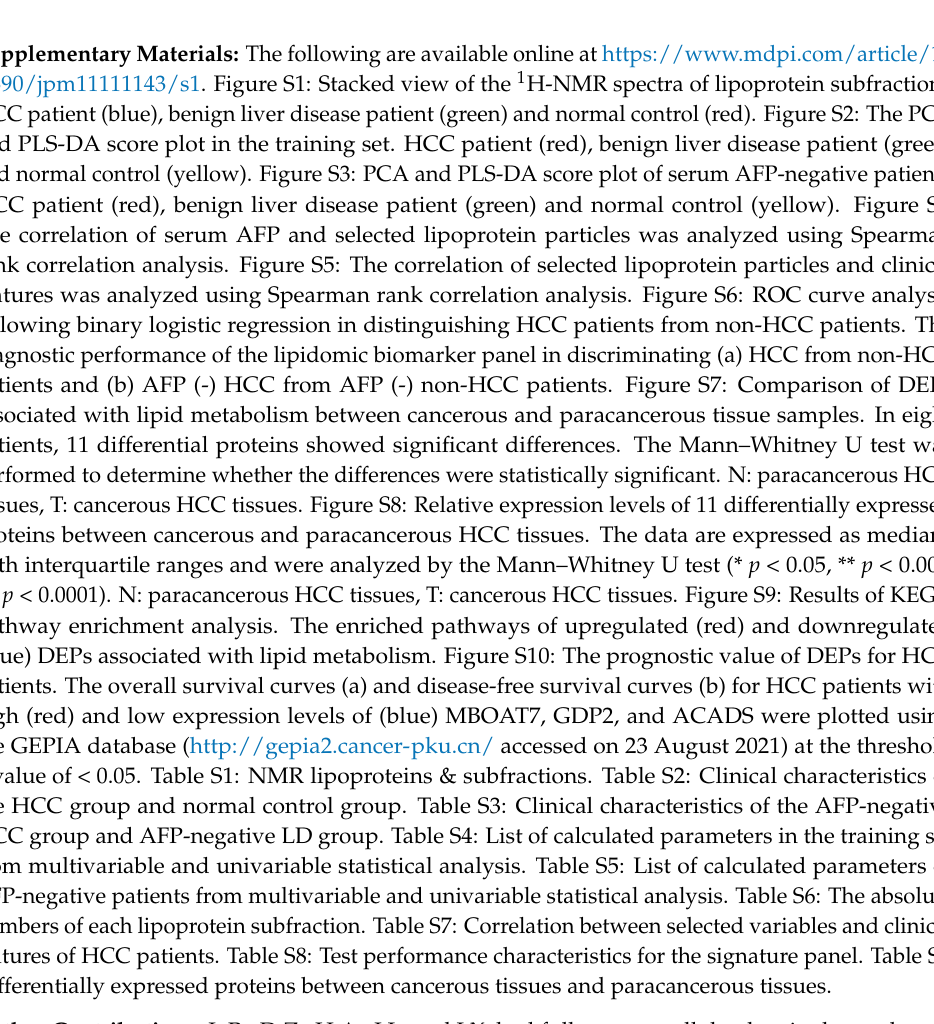
features of HCC patients. Table S8: Test performance characteristics for the signature panel. Table S9: Differentially expressed proteins between cancerous tissues and paracancerous